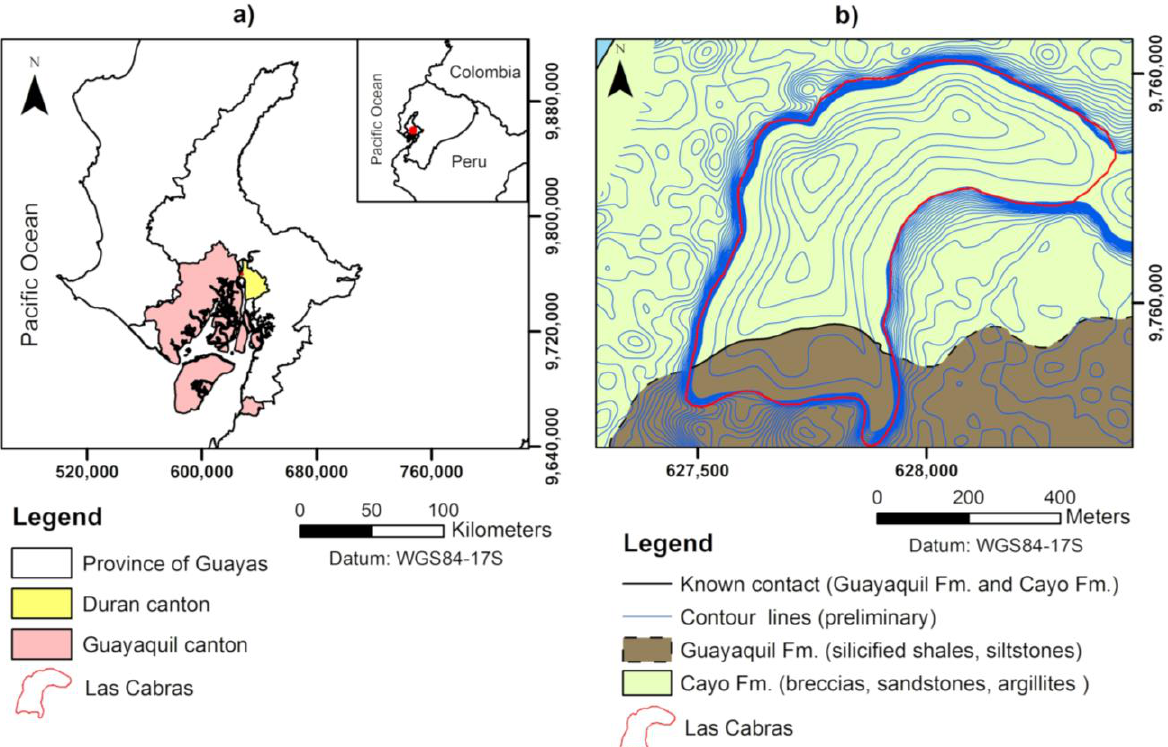
Figure 1. Location of the study area: ( a ) locations of Duran and Guayaquil cantons within the Province of Guayas, Ecuador; and ( b ) geology of the study area.